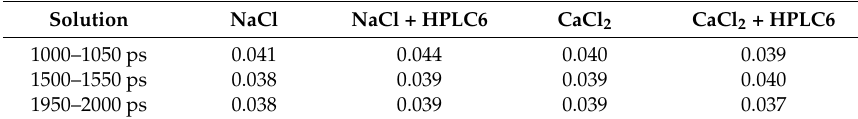
Table 5. Average values of the tetrahedricity parameter.